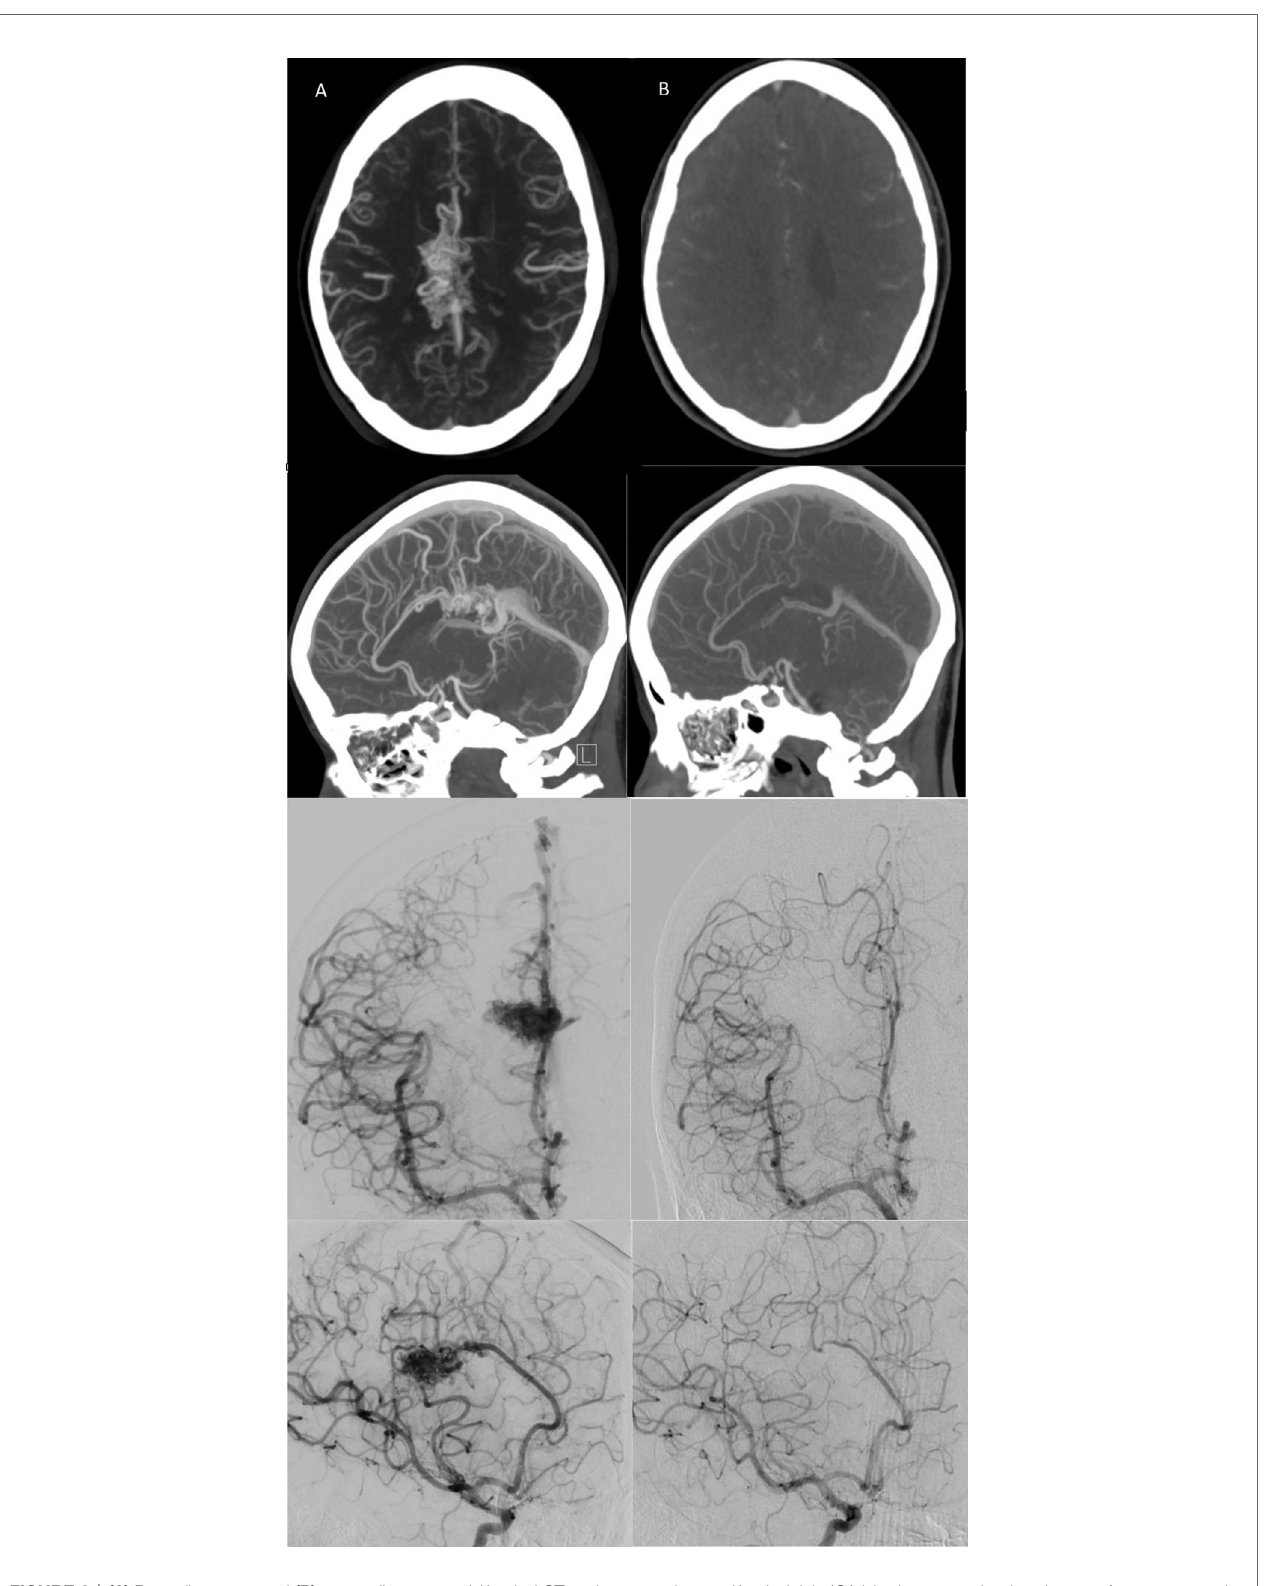
FIGURE 2 | (A) Pre-radiosurgery, and (B) post-radiosurgery axial/sagittal CT angiogram and coronal/sagittal right ICA injection conventional angiograms for a representative case with follow-up images taken at 3 years post-CyberKnife treatment demonstrating complete AVM nidal obliteration with no residual draining